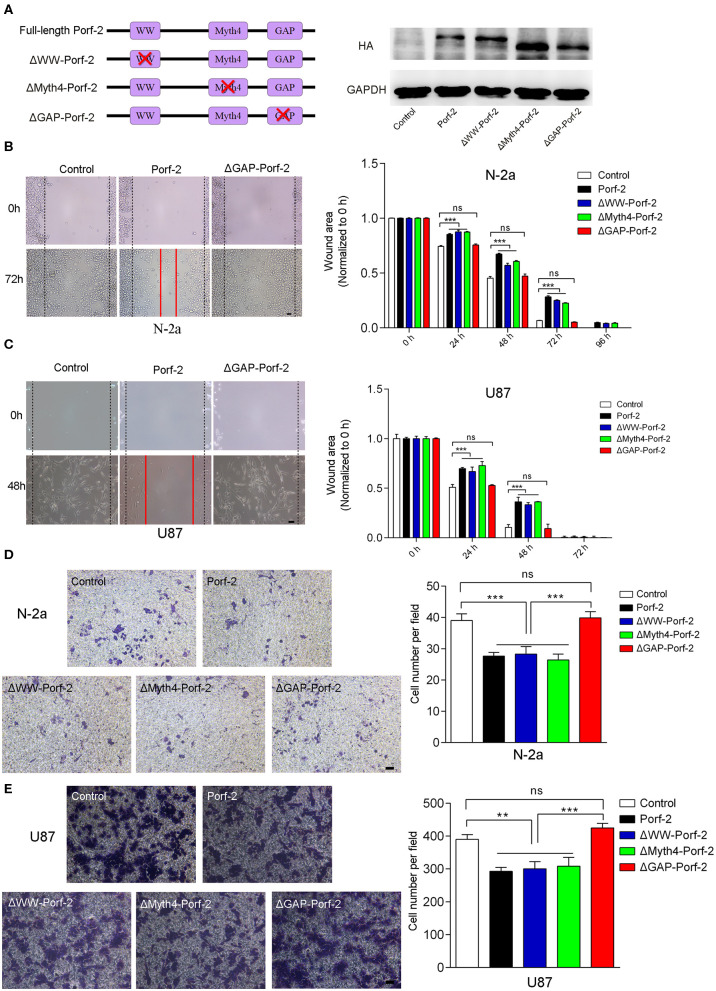
The GAP domain is required for both glioma and neuroblastoma cell migration. (A) The construct scheme of the domain-deleted plasmids of Porf-2. Verification of domain-deleted plasmids via western blotting with the HA antibody. The same blot was probed with GAPDH antibody as a loading control. (B) Representative images of the wound healing assay of N-2a cells at different time points in different groups. Quantification of the wound area at indicated time points in different groups. Scale bar, 200 μm. (C) Representative images of the wound healing assay of U87 cells at different time points in different groups. Scale bar, 200 μm. (D) Representative images of the migrated N-2a cells in different groups. Quantification of the migrated cells in each group. Scale bar, 200 μm. (E) Representative images of the migrated U87 cells in different groups. Quantification of the migrated cells in each group. Scale bar, 200 μm. Error bars represent ± SEM; ns indicates no significant difference (P > 0.05). **P < 0.01, ***P < 0.001.